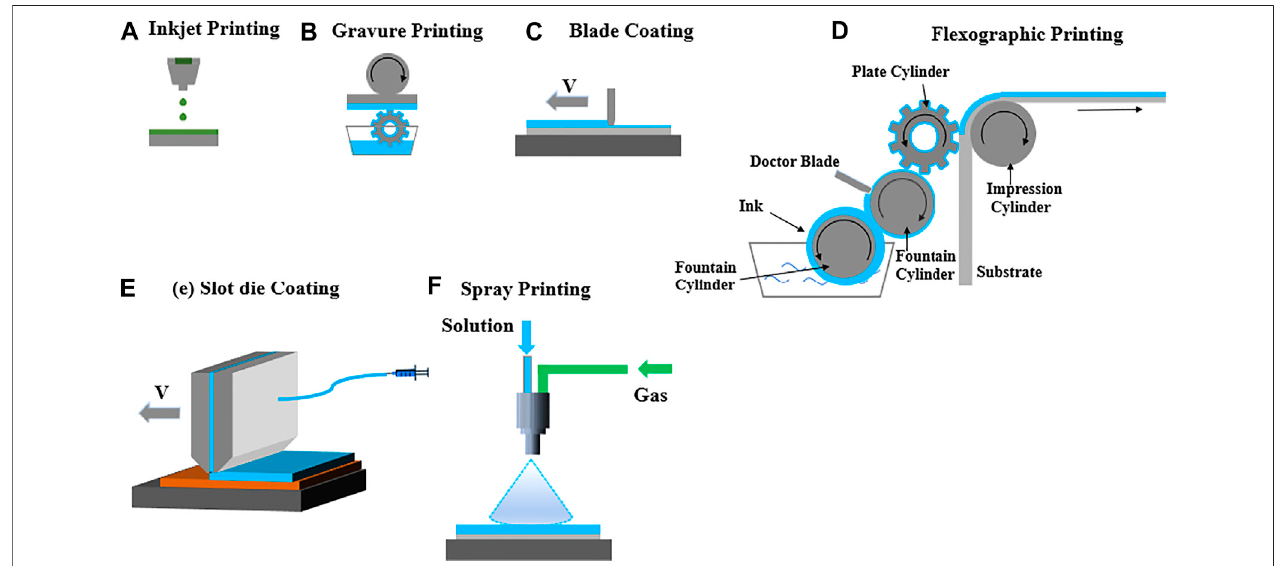
FIGURE 5 | Types of roll-to-roll fabrication techniques.